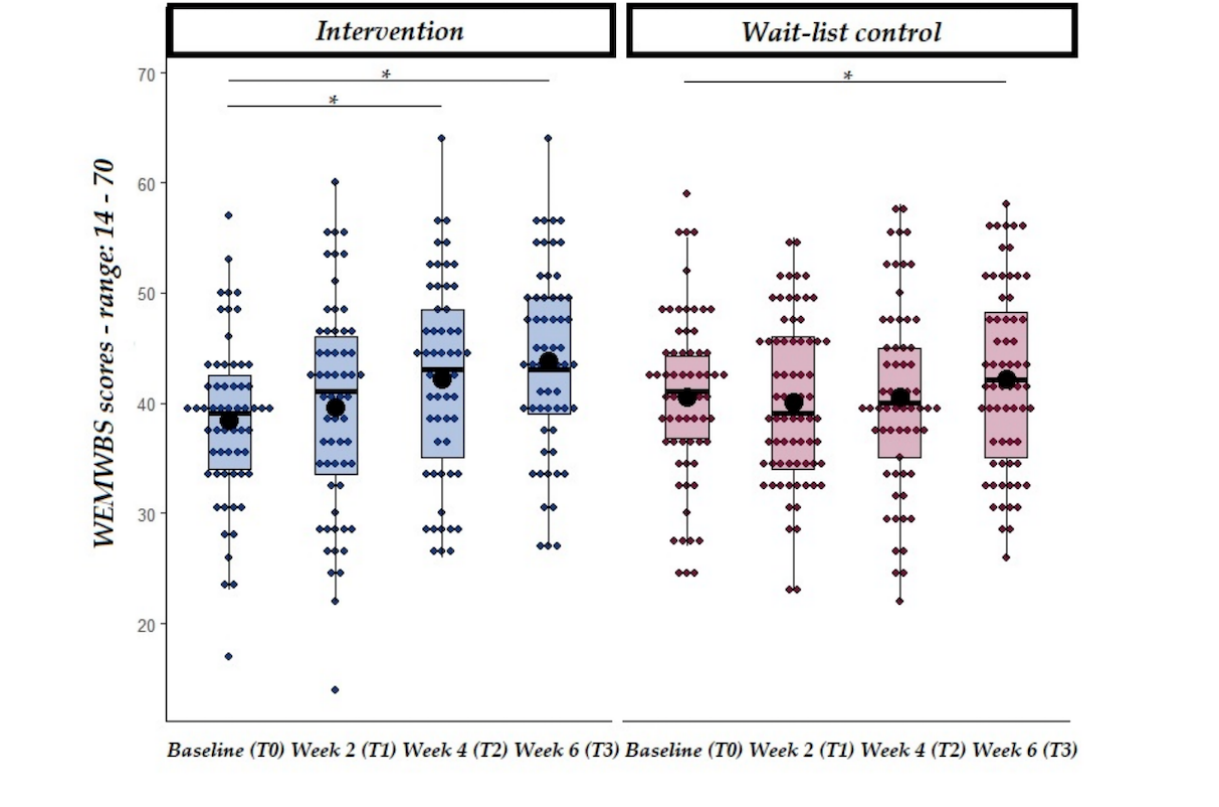
Figure 4. WEMWBS scores at baseline, week 2, week 4 and follow-up from the start of the intervention in both intervention and wait-list control groups. Solid line=median; black dot=mean; whiskers: upper whisker=min(max(x), Q_3 + 1.5 x IQR); lower whisker=max(min(x), Q_1 - 1.5 x IQR). * P <.05.